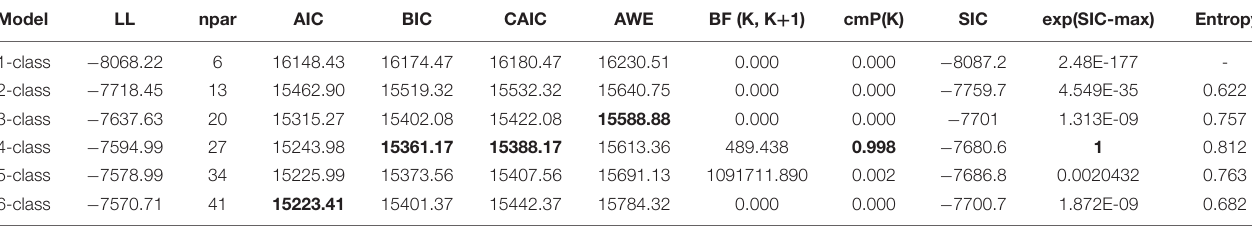
TABLE 2 | Latent class solution of student behaviors at the year 2017.